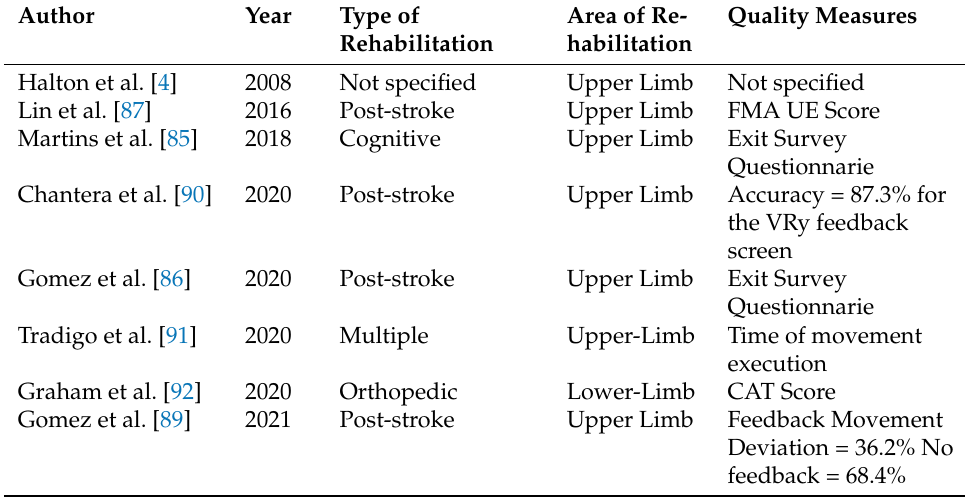
Table 5. Virtual rehabilitation implementation